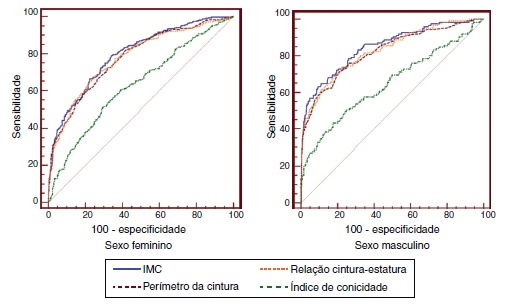
Área sob a curva ROC de indicadores antropométricos para predizer a
gordura corporal em adolescentes.